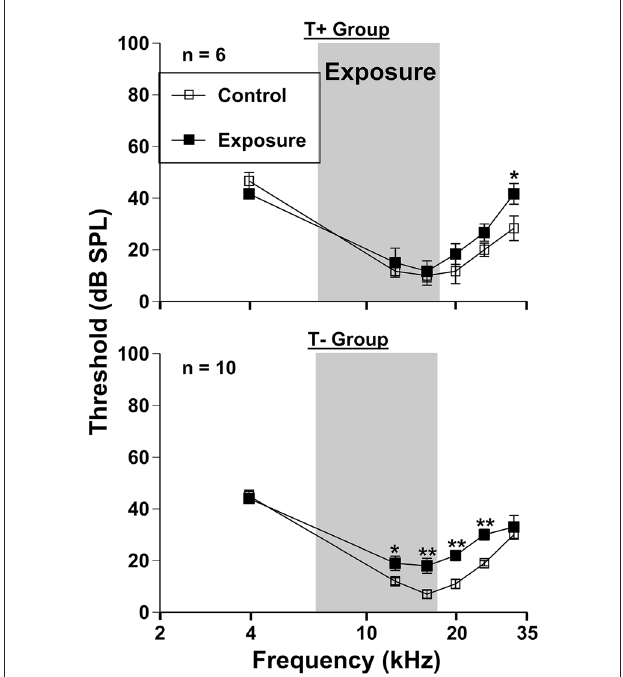
FIGURE 3 | Auditory thresholds assessed via auditory brainstem response (ABR) grouped by T + ( n = 6) and T − ( n = 10) animals (from Figure 1B). Mice were tested before (control) and 3 months (exposed 3M) after sound exposure. The narrow band exposure stimulus is represented by a gray box.